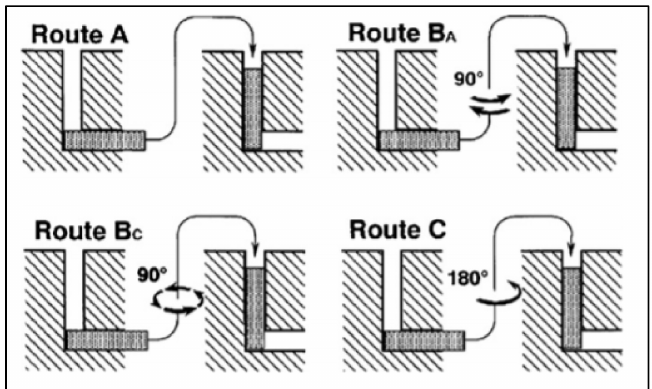
Figure 1. Four routes in the ECAP process.